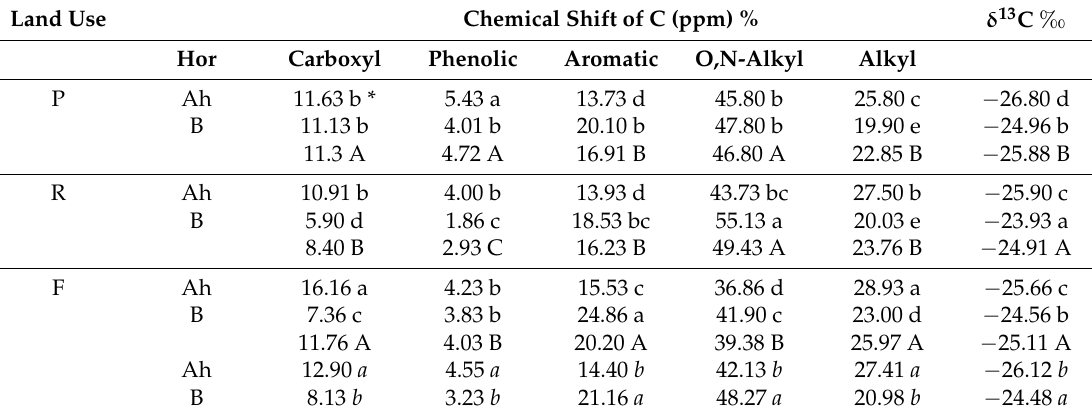
Table 2. Distribution of C determined 13 C-NMR and δ 13 C in the three land use types, Cortina d’Ampezzo Valley,